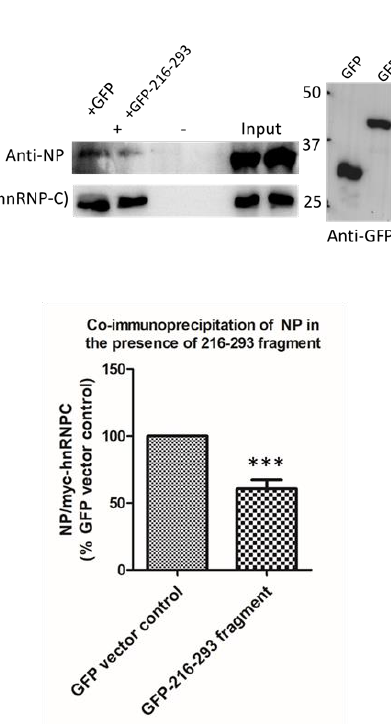
Figure 4. ( A ) Co-immunoprecipitation in HEK293T cells overexpressing GFP (control) or GFP–216–293 fragment. In the presence of GFP–216–293, only 60.5% of it, compared with vector control, could be co-immunoprecipitated by myc–hnRNP-C. ***: p < 0.001, two-tailed Student’s t -test, error bar represents standard deviation over n = 3 experiments; +: myc antibody added; − : negative controls without myc antibody ( B ) Flag 216–293 was co-transfected to HEK293T cells along with the influenza minireplicon. A drop in luciferase signal to 63.8% (**: p < 0.01, two-tailed Student’s t -test) was observed when compared to pCMV-Tag2B vector control. The error bar represents the standard deviation over n = 4 experiments.